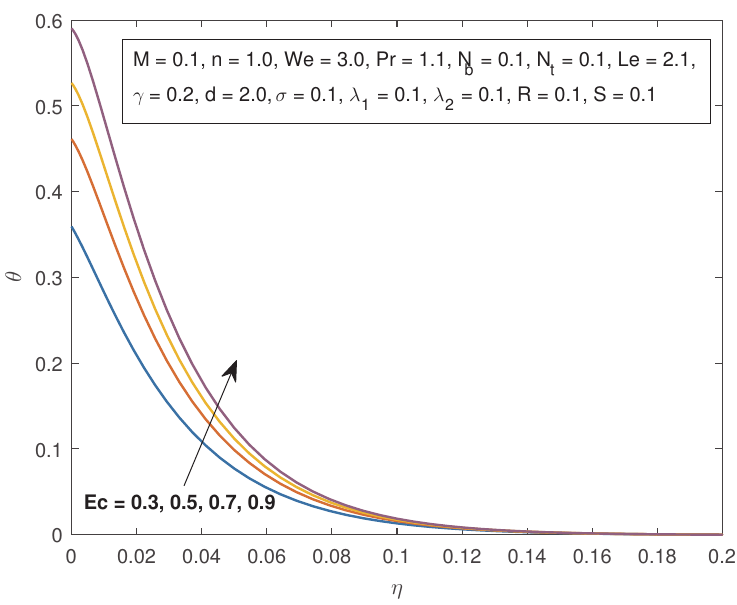
Figure 10. Influence of Ec on the fluid temperature.